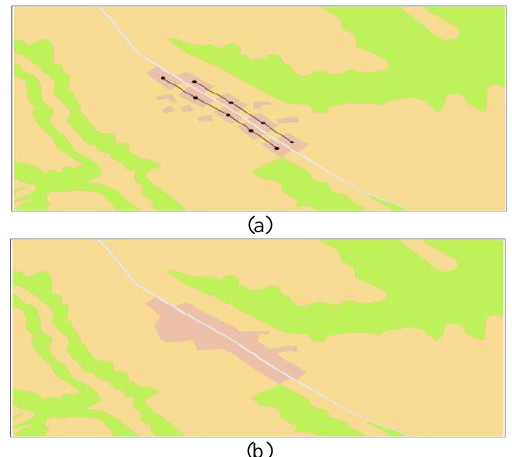
Figure 2. Buildings arranged in a linear pattern. (a) Original data; (b) loss of linear